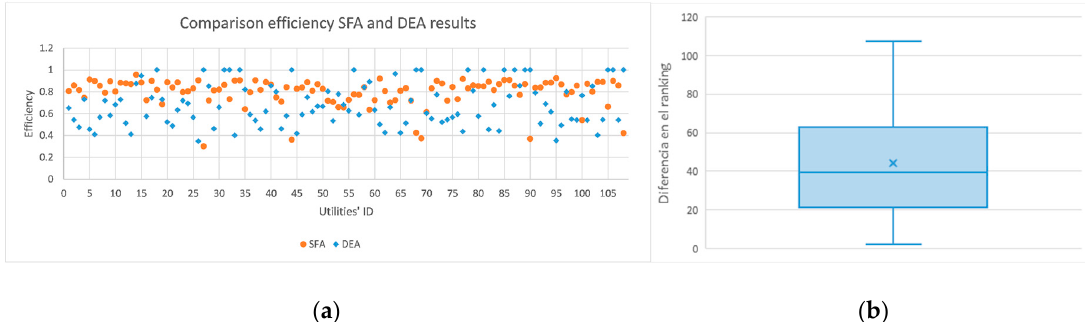
Figure 4. Comparison of the e ffi ciency scores from the reduced sample for SFA and DEA models: ( a ) e ffi ciency results for both SFA and DEA models: ( b ) di ff erences in the ranking positions between both